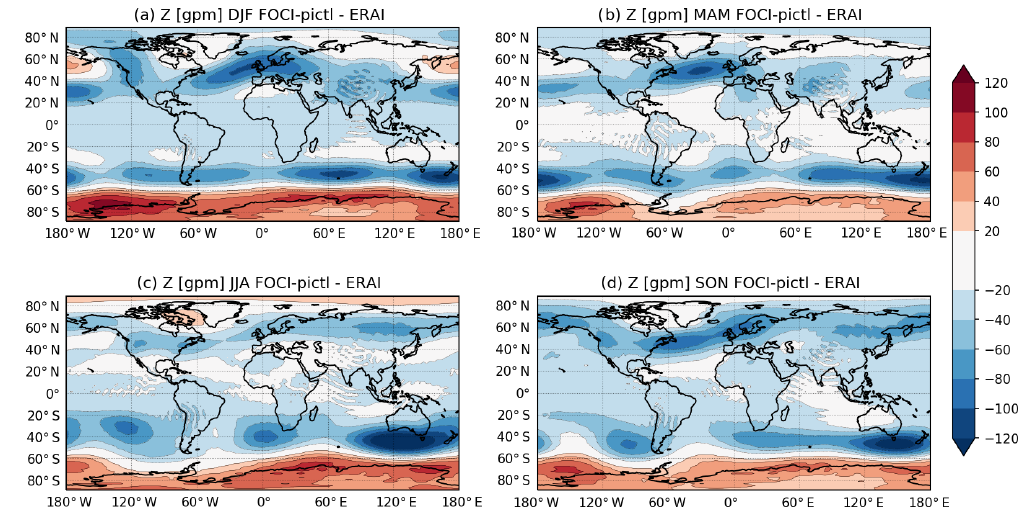
Figure A3. Seasonal mean geopotential bias – (a) DJF, (b) MAM, (c) JJA and (d) SON – at 500hPa with respect to ERA-Interim (1980– 2013).